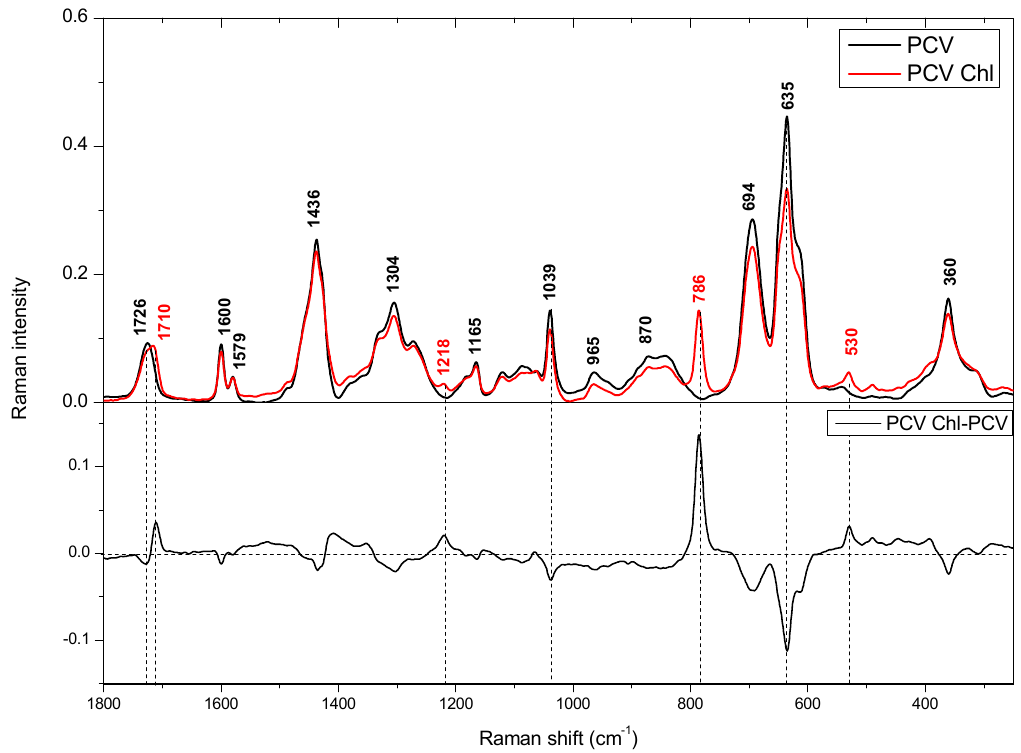
Figure 9. The FT Raman spectra of PVC (black line) and PVC with adsorbed chlorophyll (PVC-Chl, red line) in the range 1800–250 cm − 1 (upward panel). Downward panel presents differential spectrum.